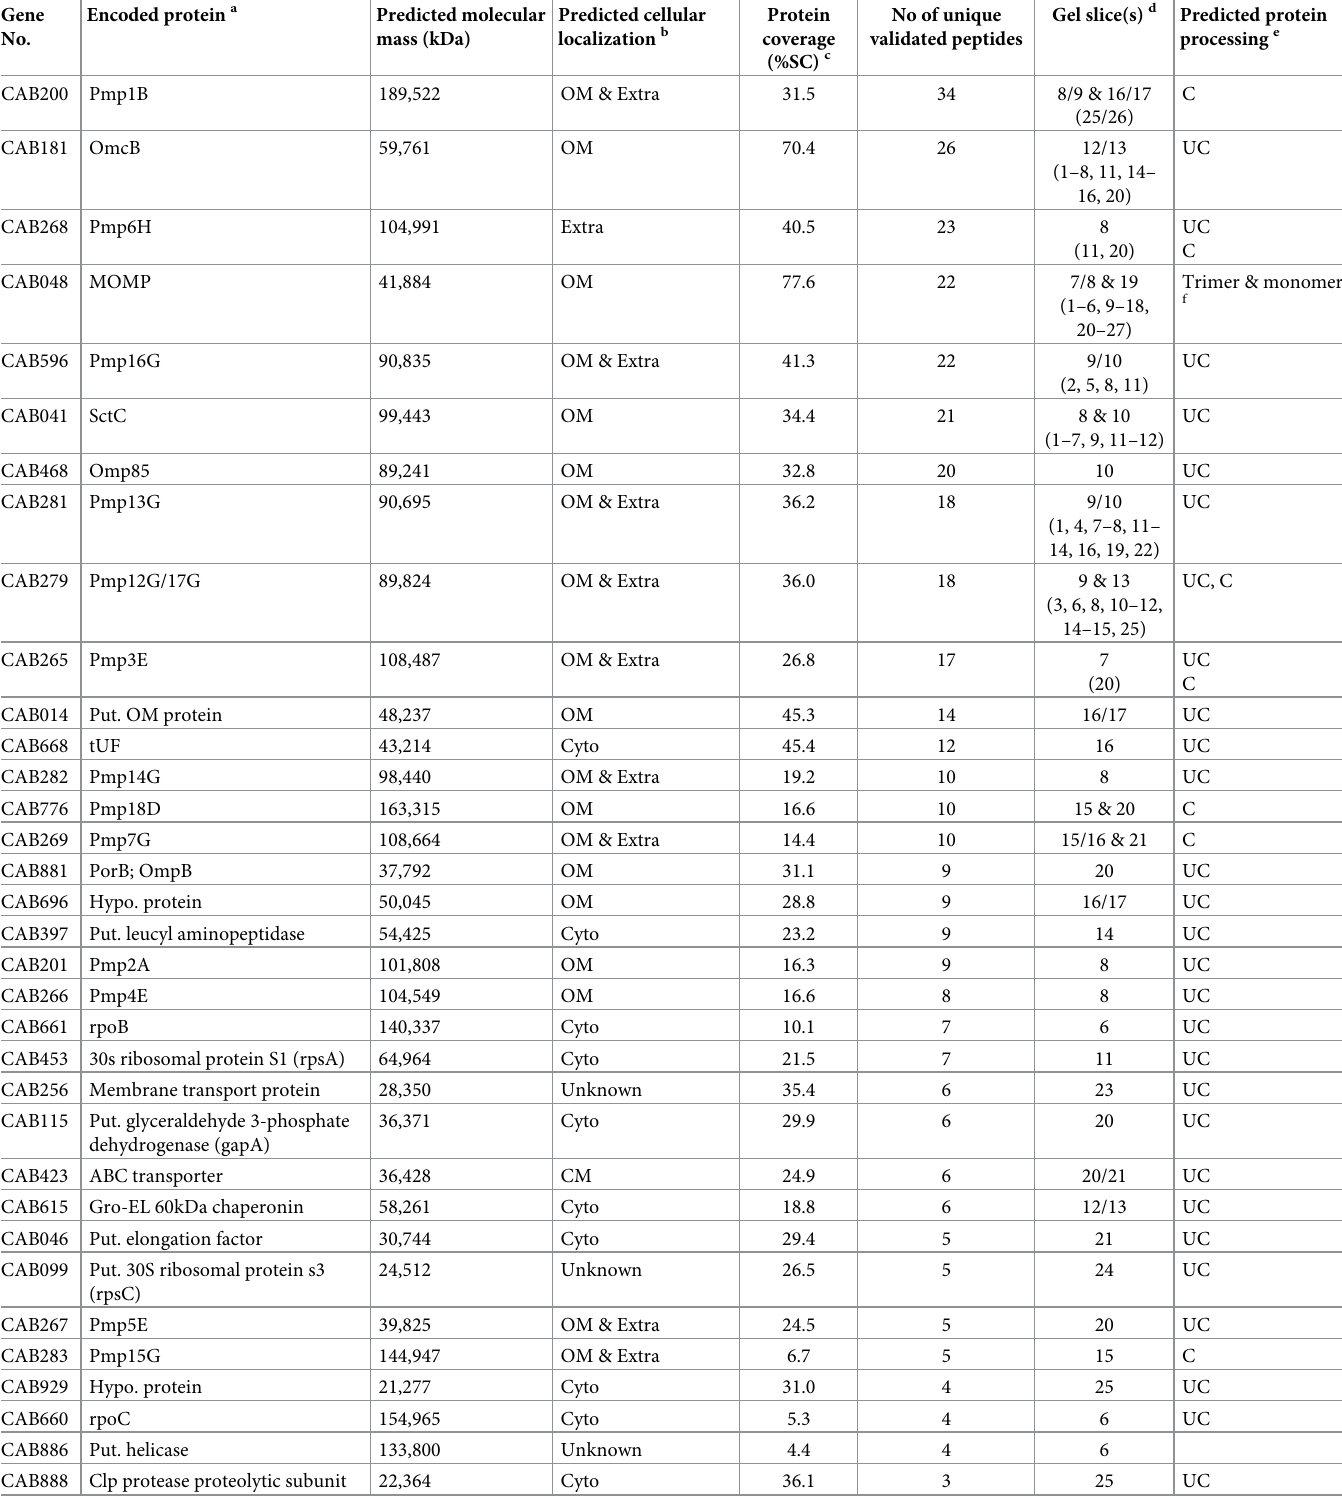
Table 1. Proteins from C . abortus S26/3 COMC identified with two or more valid peptides. Gene